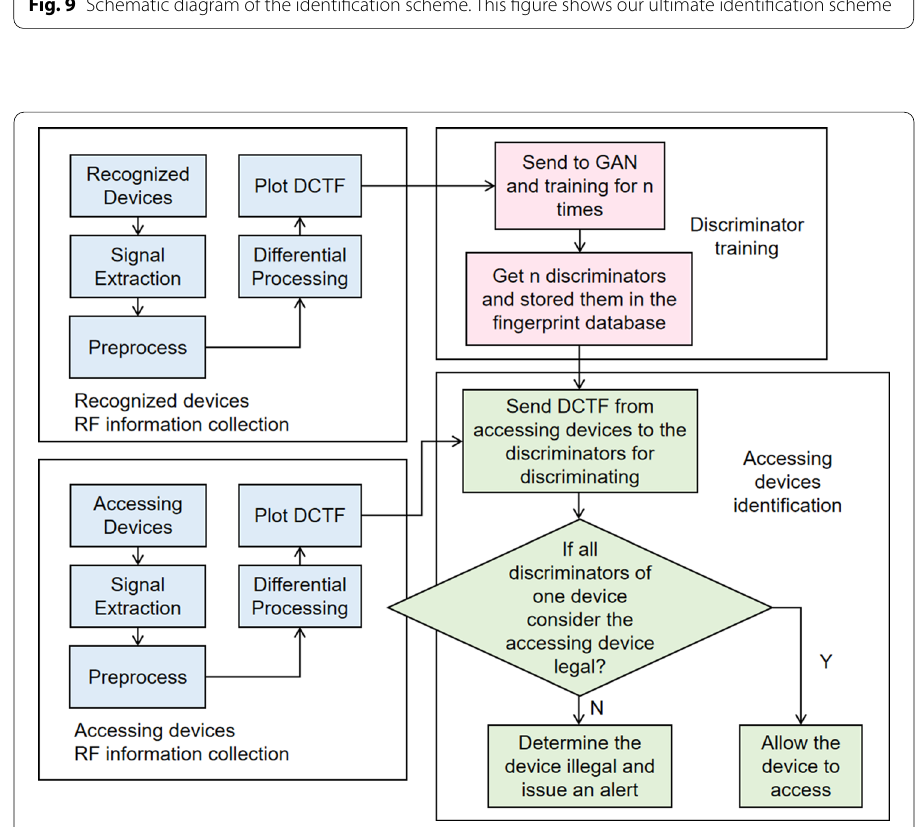
Fig. 10 The flowchart of accessing devices verification system. This figure shows the flow chart of the entire identification